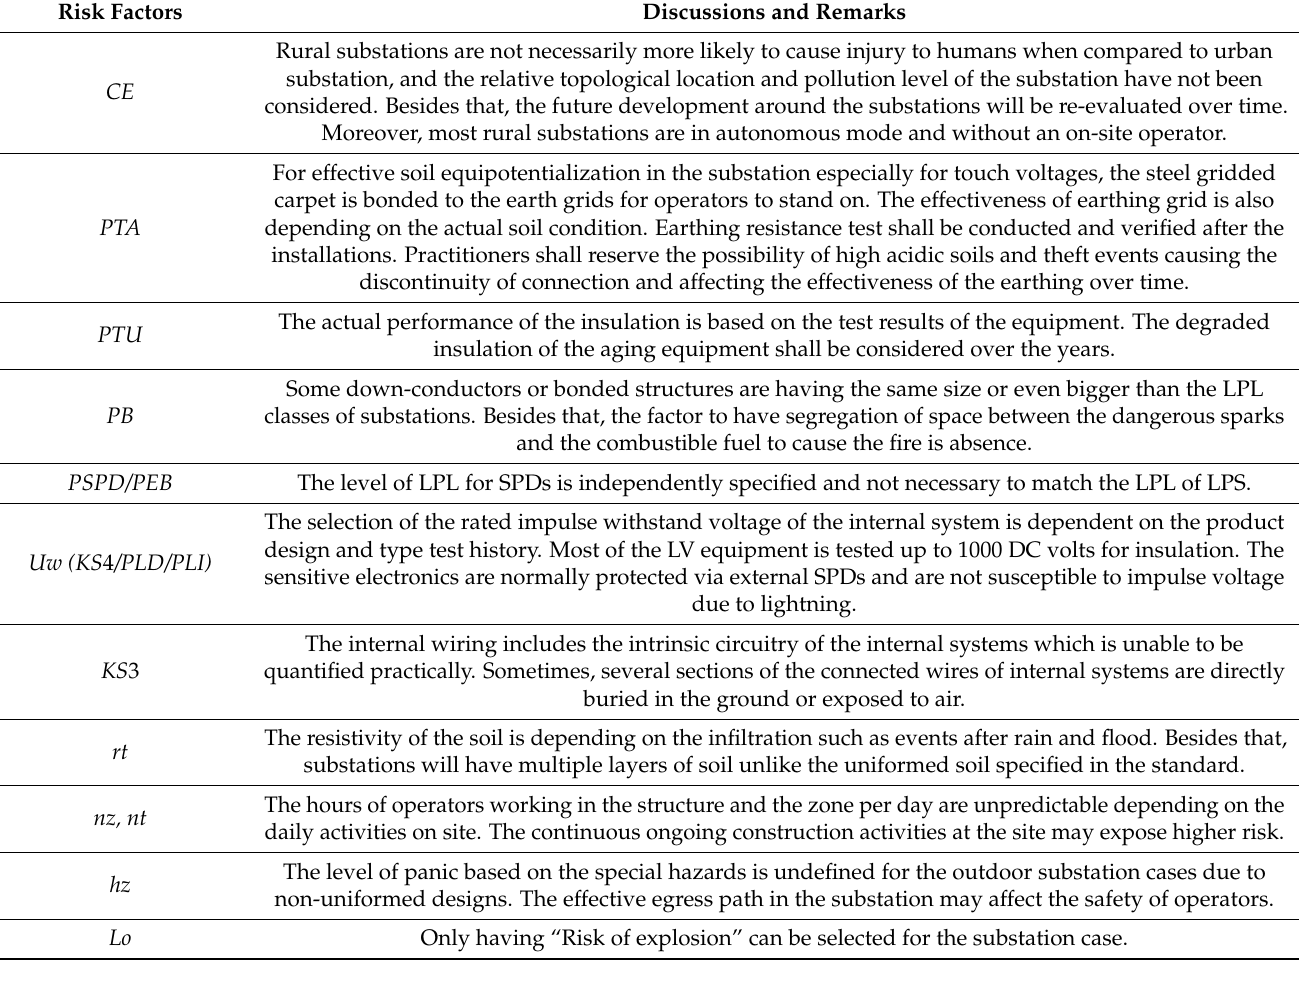
Table 13. Ambiguous Risk Criteria.